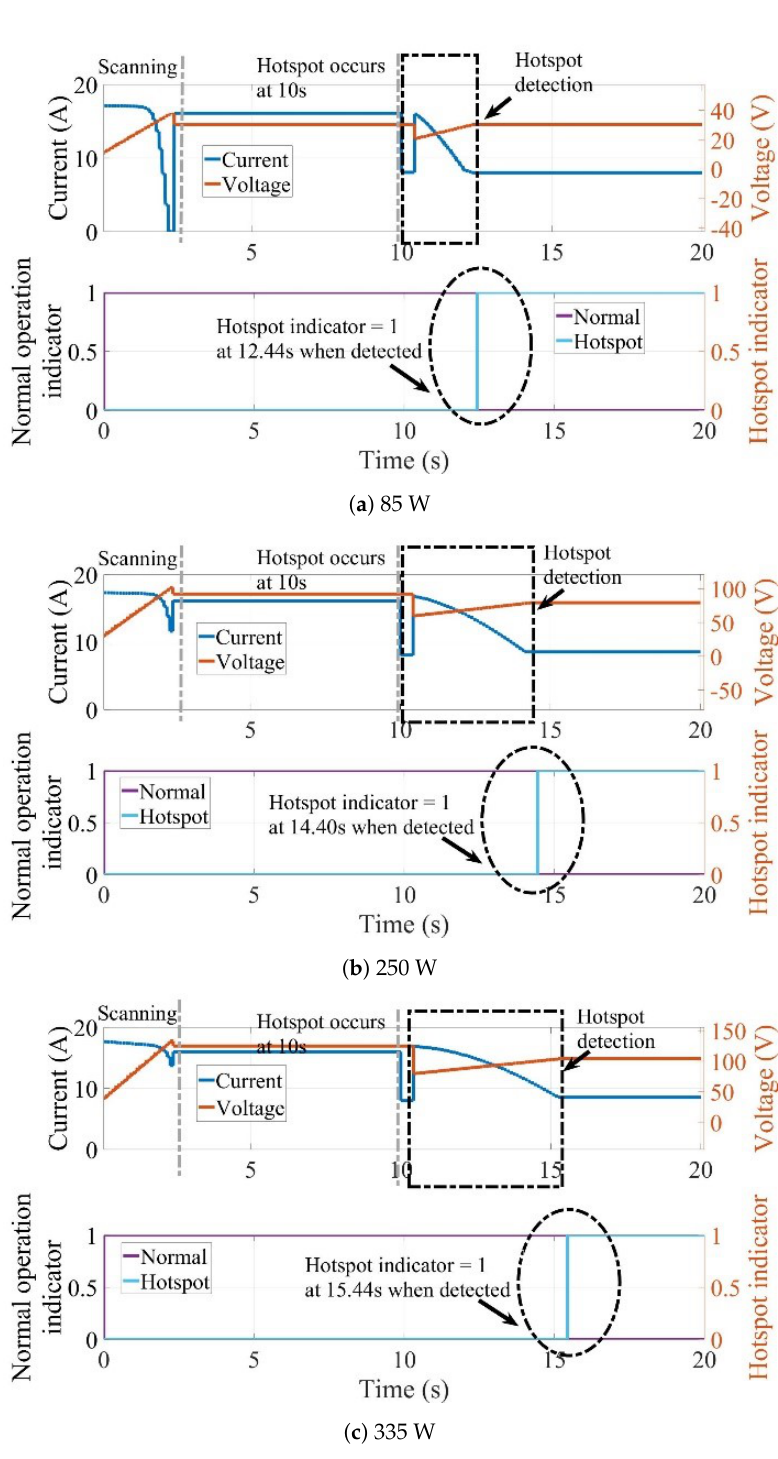
Figure 15. Simulation result for the proposed hotspot detection algorithm using different PV